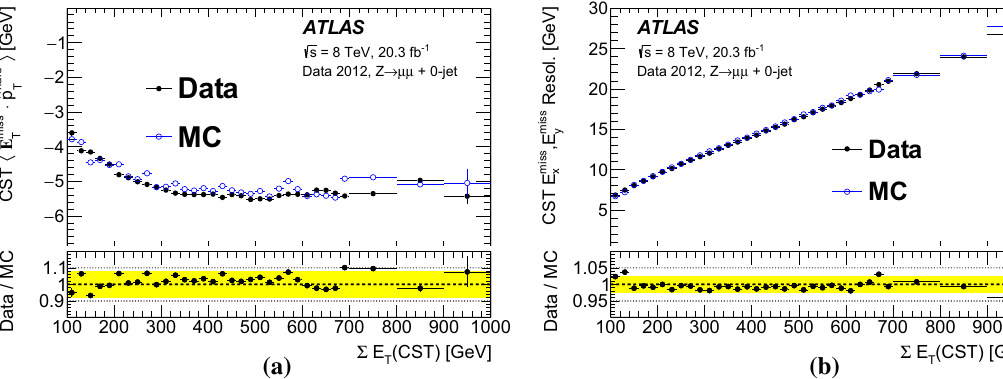
Fig. 21 The a projection of CST (cid:3) E miss width (resol.) of the combined distribution of CST E miss x and E miss y are shown versus (cid:5) E T (CST). The ratio of data to MC simulation is shown